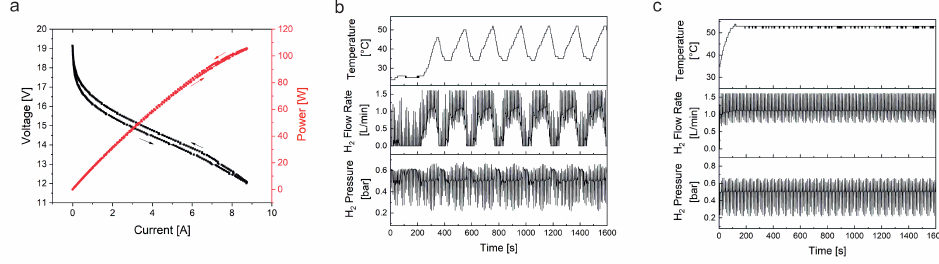
Figure 8. ( a ) Representative polarization curve of the investigated fuel cell stack. ( b ) Typical pressure, flow rate, and fuel cell stack temperature chart recorded during the dynamic load cycle. ( c ) Respective chart for the high load cycle. Please note that the observed spikes in the pressure and flow rate charts are due to the exhaust gas valve which is automatically opened every 10